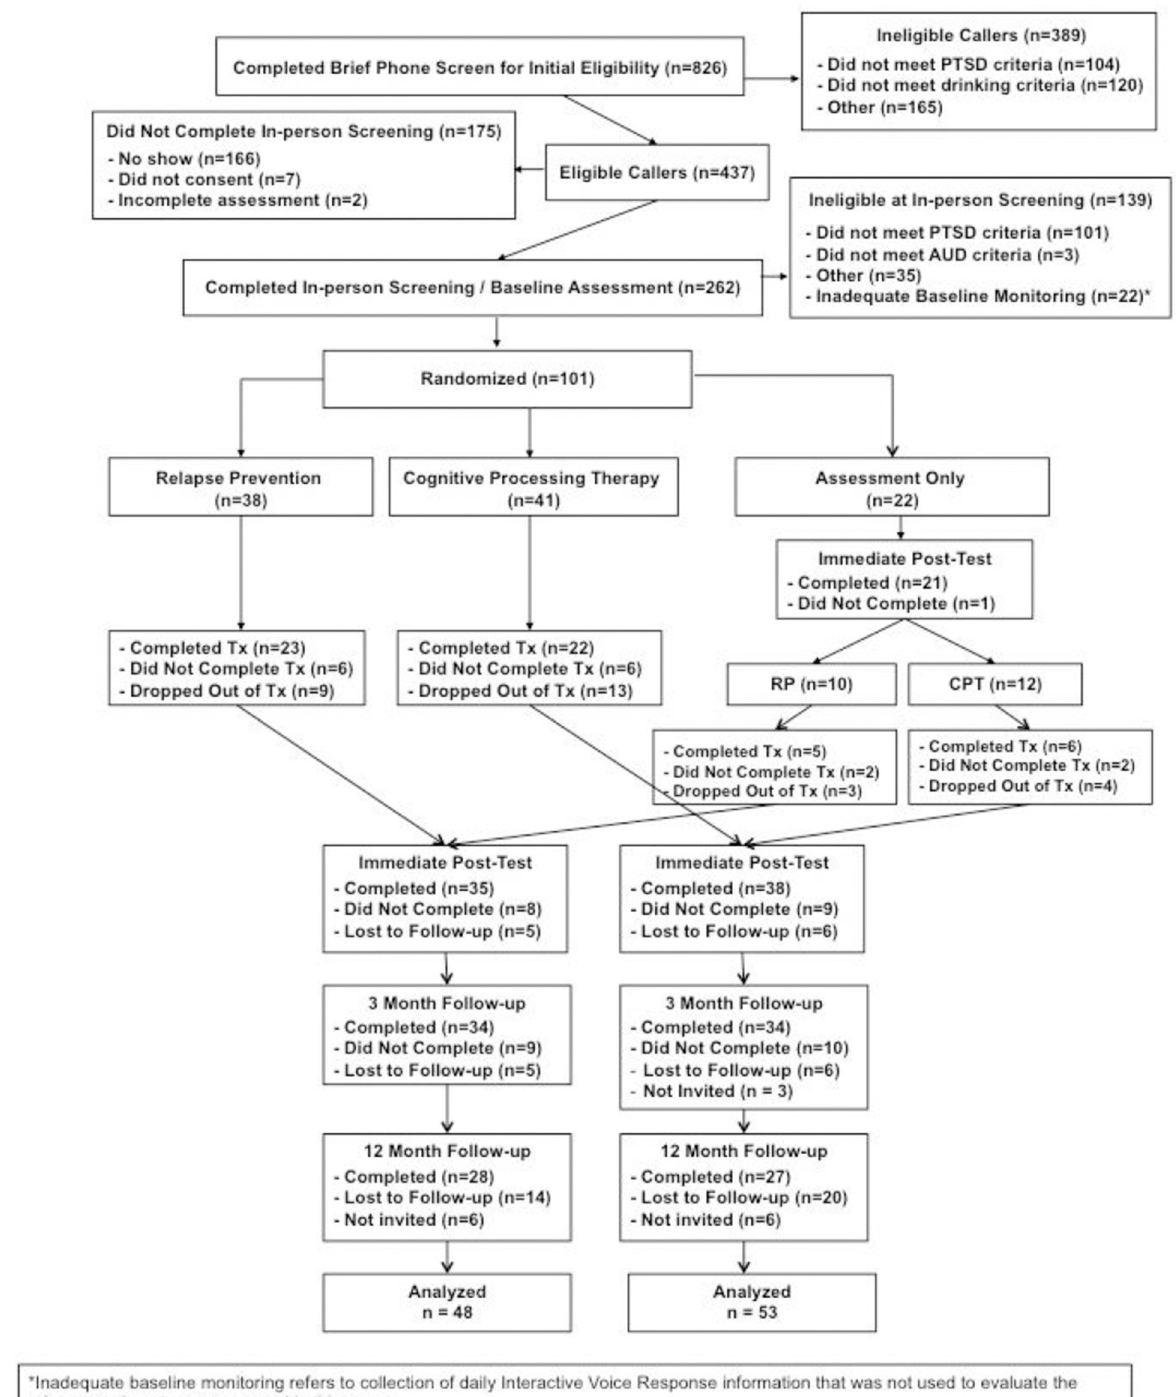
Fig 1. CONSORT diagram.